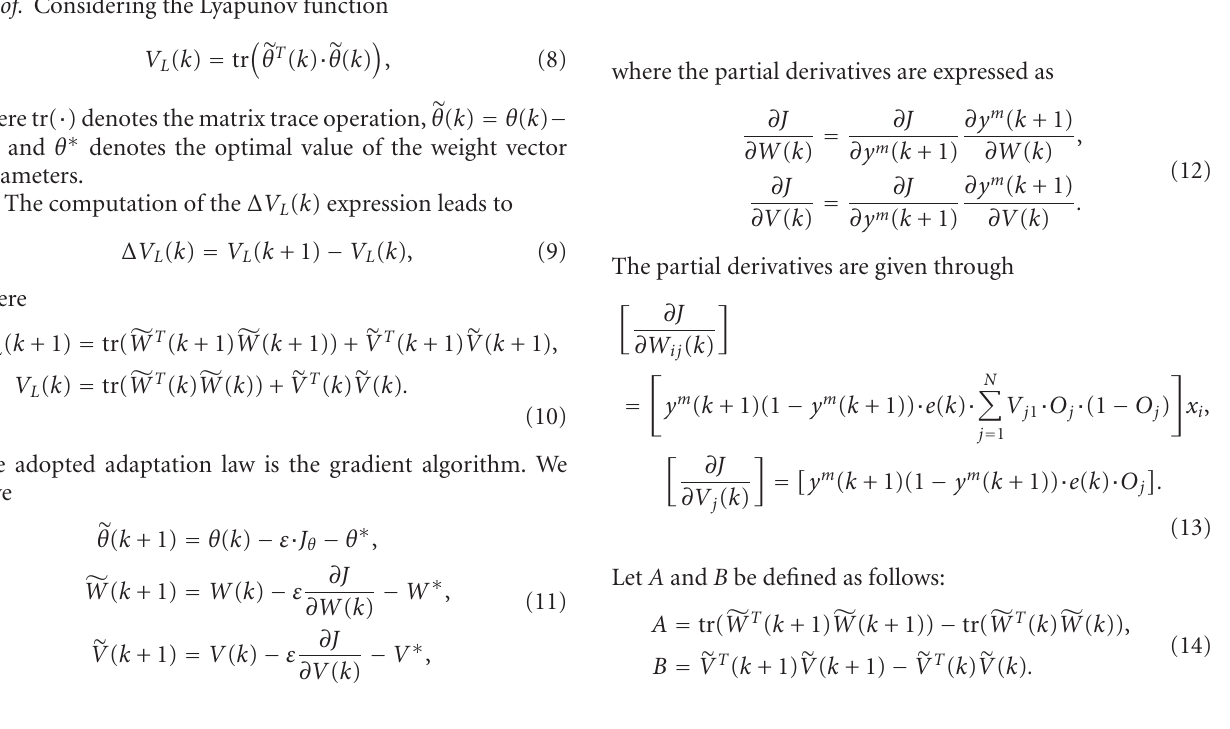
Figure 3: Evolution of the system output and the neural model output ( ε / ∈ stability